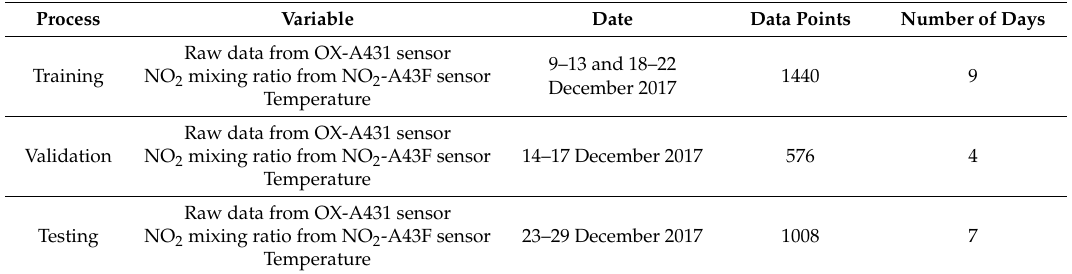
Table 2. List parameters which used for the training, testing and validation during the field calibration.